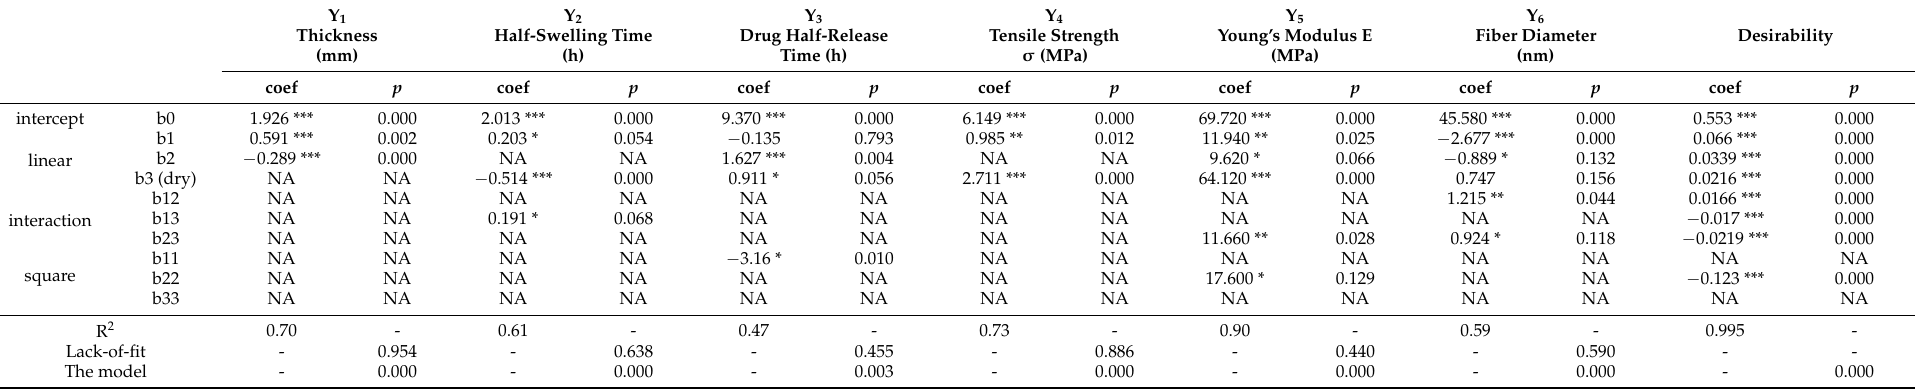
Table 3. Model parameters (coded coefficients), p values, and goodness-of-fit statistics obtained by response surface methodology (RSM) for each of the 6 response variables